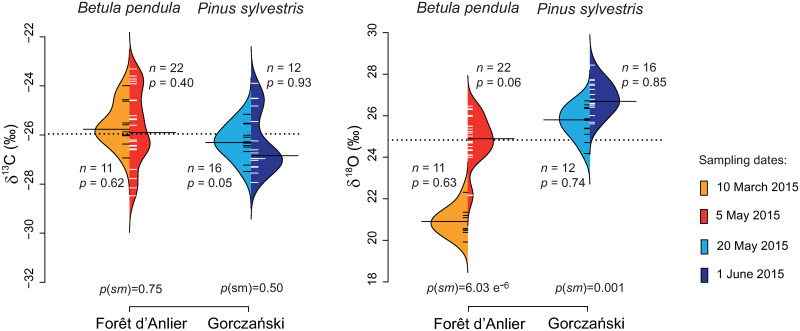
Intra-annual comparison of δ13Cpollen and δ18Opollen values of Betula pendula (Forêt d’Anlier) and Pinus sylvestris (Gorczański).Both species were sampled twice in 2015. The bean plots show δ13Cpollen values (left) and δ18Opollen values (right). Colours indicate the sampling date (orange = 10 March 2015; red = 5 May 2015; light blue = 20 May 2015; dark blue = 1 June 2015). n is the number of individuals sampled. The p-values indicate whether the pollen-isotope values of one year are normally distributed (sign. level = 0.05), whereas p(sm) represents the probability for equal medians in samples of the same year. The dotted line represents the mean over all localities and both years. The means of each sampling are indicated by a black bar.